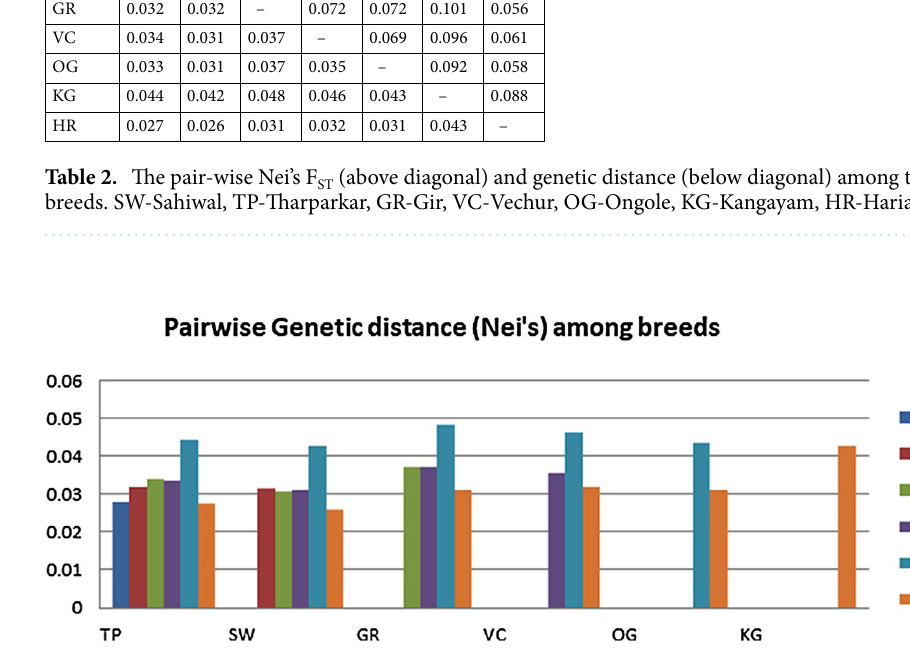
Figure 2. Pair-wise Genetic distance (Nei’s) among breeds. The abbreviations are defined below: TP— Tharparkar, SW—Sahiwal, GR—Gir, VC—Vechur, OG—Ongole, KG—Kangayam,